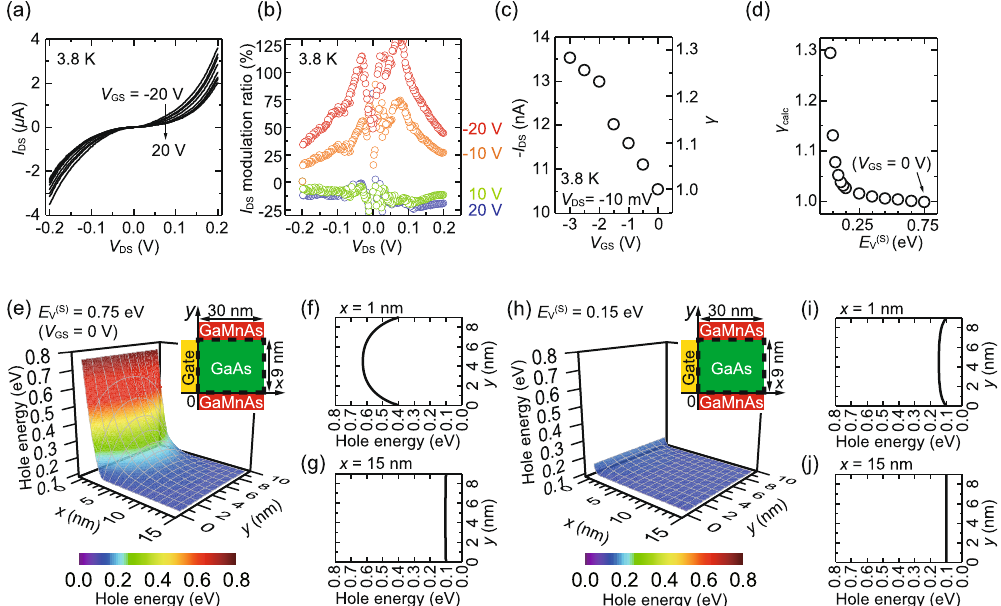
Figure 2. ( a ) Drain-source current I DS as a function of the drain-source voltage V DS with the gate-source voltage V GS ranging from − 20 V to 20 V with a step of 5 V at 3.8 K. ( b ) I DS modulation ratio as a function of V DS with various V GS at 3.8 K. ( c ) Drain-source current ( − I DS ) (left axis) and the I DS value normalized at V GS = 0 V ( γ ) (right axis) as a function of V GS with V DS = − 10 mV at 3.8 K. ( d ) Calculated I DS normalized by the one at V GS = 0 V ( γ calc ) as a function of E V(S) . ( e , h ) Calculated valence band top energy E V with respect to the Fermi level when E V(S) = 0.75 eV ( e ) and E V(S) = 0.15 eV ( h ). Here, the Fermi level corresponds to 0 eV. The vertical axis expresses the hole energy. The inset in ( e ) and ( h ) shows the structure used in our calculation. Here, the x axis represents the distance from the side surface of the mesa and the y axis denotes the distance from the interface between the bottom GaMnAs layer and the intermediate GaAs layer. The calculation was performed in the region surrounded by the dashed line. In ( e , h ), only the region of 0 nm ≤ x ≤ 15 nm is shown because it is sufficient to see how the gate electric field influences the valence band maximum energy in the GaAs layer. ( f , g ) E V vs . y at x = 1 nm ( f ) and 15 nm ( g ) when E V(S) = 0.75 eV. ( i , j ) E V vs . y at x = 1 nm ( i ) and 15 nm ( j ) when E V(S) = 0.15